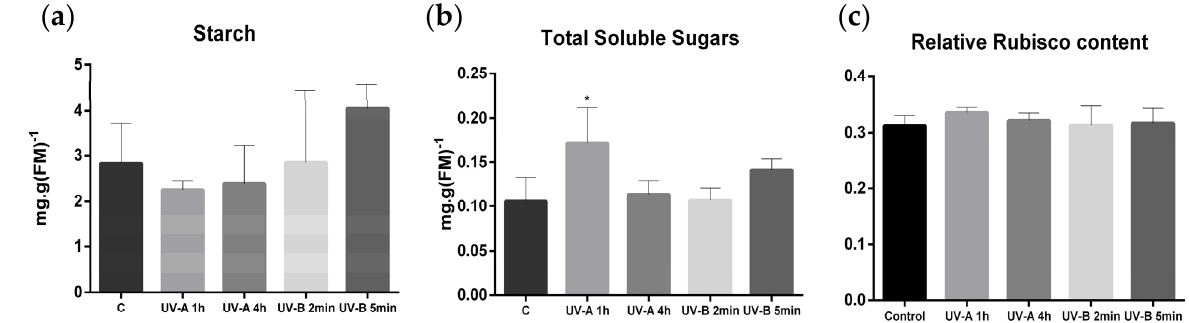
Figure 3. Carbon fixation in plants exposed 30 d to different UV-A/B conditions. Starch ( a ), Total Soluble Sugars ( b ), and Relative RuBisCO content ( c ) values. FM (Fresh Matter). Within each parameter, * represent significant differences for p < 0.05. Values are expressed as the mean and standard deviation (n = 10).